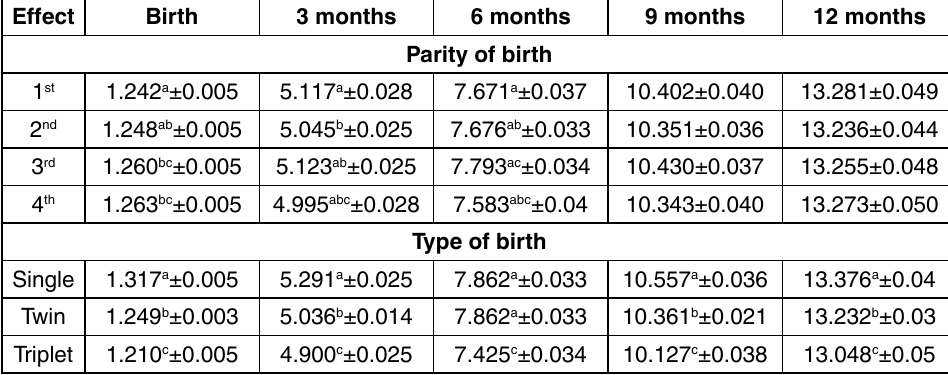
Table 3. Parity and birth type wise variation of body weight (Mean ± SE) of Black Effect Birth